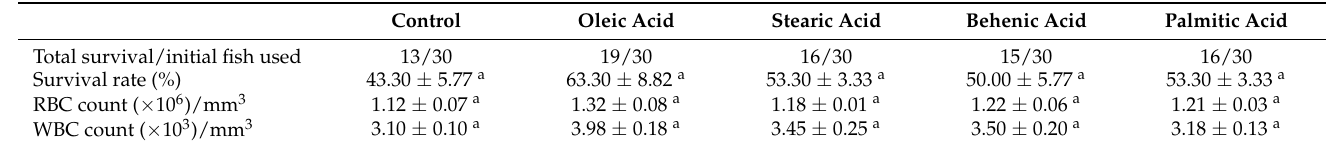
Different superscripts in the same row indicate a significant difference ( p < 0.05) between different fatty acid diets. Values are averages ± SE. RBC; red blood cells; WBC, white blood cells. (non-parametric Kruskal–Wallis’s test followed by Kruskal–Wallis post-hoc multiple comparison